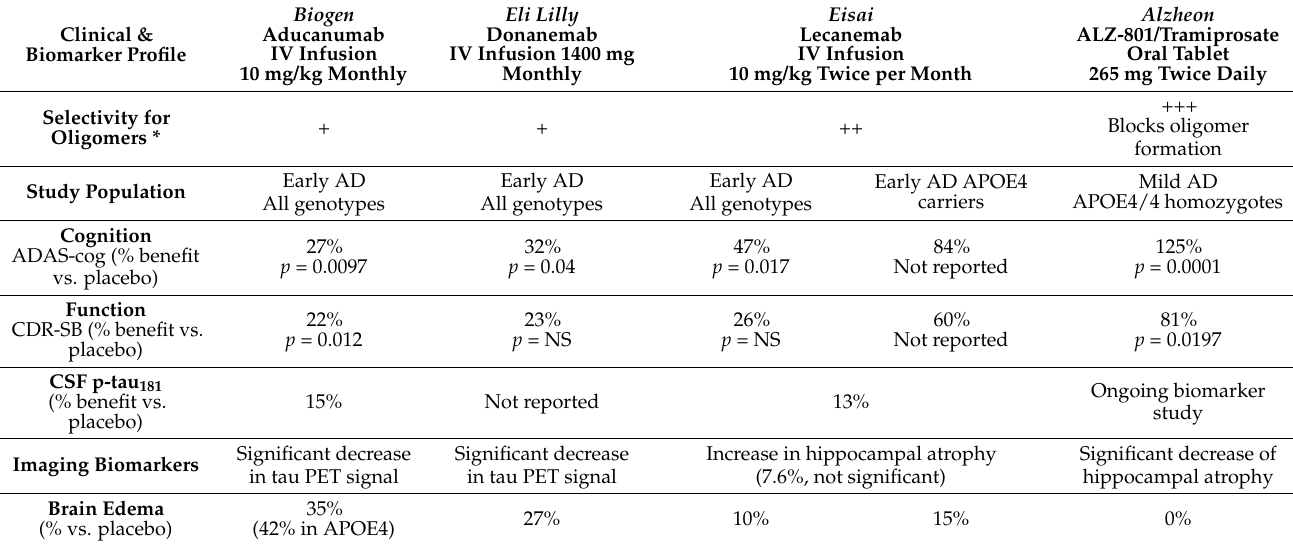
Table 1. Engagement of oligomers drives clinical and biomarker effects of anti-amyloid agents. To date, four anti-amyloid agents have shown both positive clinical effects, as well as correlation with fluid or imaging biomarkers: the intravenous antibodies aducanumab, lecanemab, donanemab, and the oral tablet ALZ-801. Aducanumab and lecanemab significantly reduced cerebrospinal fluid (CSF) levels of p-tau 181 , and aducanumab and donanemab showed significant effects on tau positron emission tomography (PET) imaging. ALZ-801/tramiprosate significantly decreased hippocampal atrophy assessed by volumetric magnetic resonance imaging (MRI) measurements